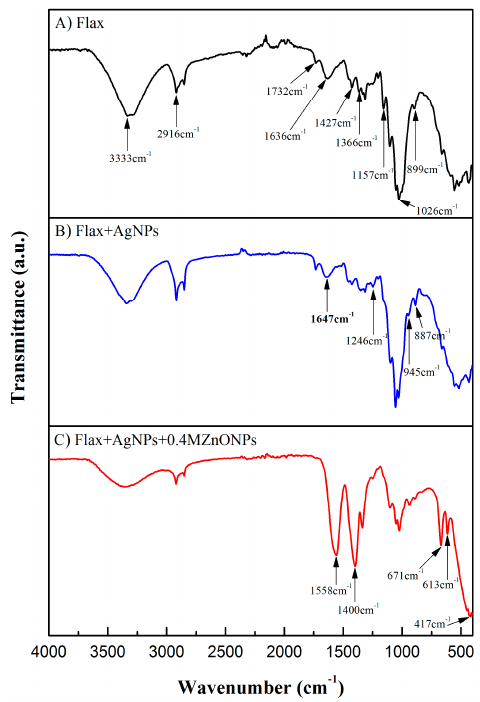
Figure 6. Attenuated Total Reflectance-Fourier Transform Infrared Spectroscopy (ATR-FTIR) spectra of flax fabric ( A ), flax functionalized with AgNPs ( B ), and flax functionalized with AgNPs and ZnONPs ( C ).